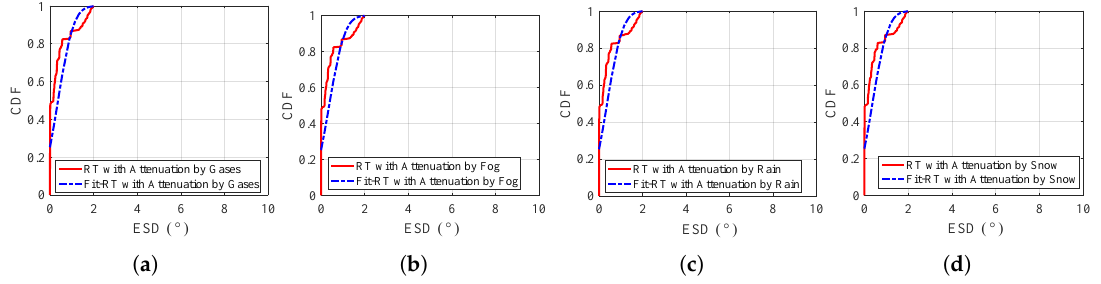
Figure 12. ESD (elevation angular spread of departure), ( a ) by Gases; ( b ) by Fog; ( c ) by Rain; ( d ) by